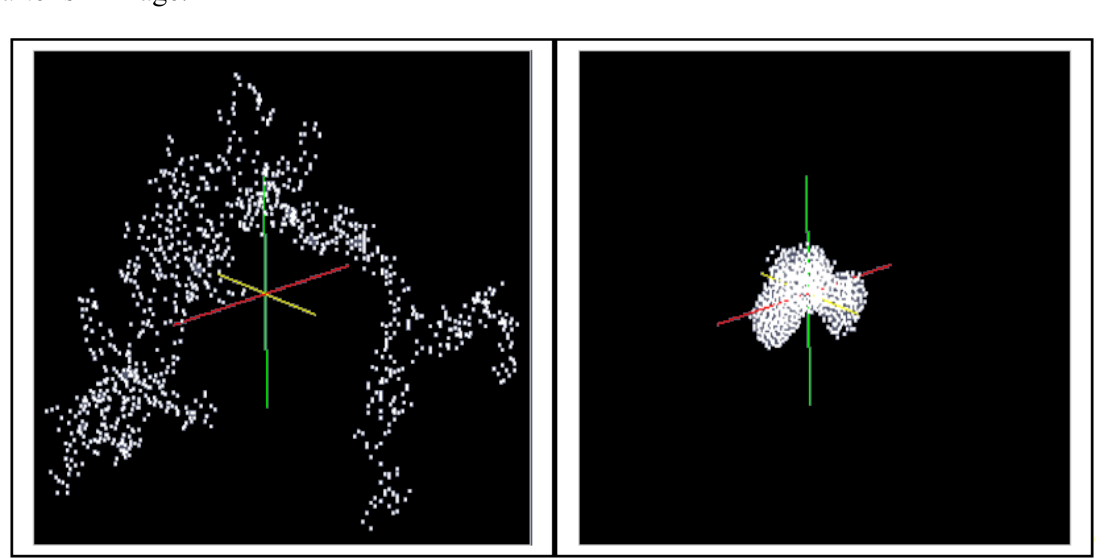
Figure 5. Structure of the model gel fragment (cluster of 1,000 particles) before and after